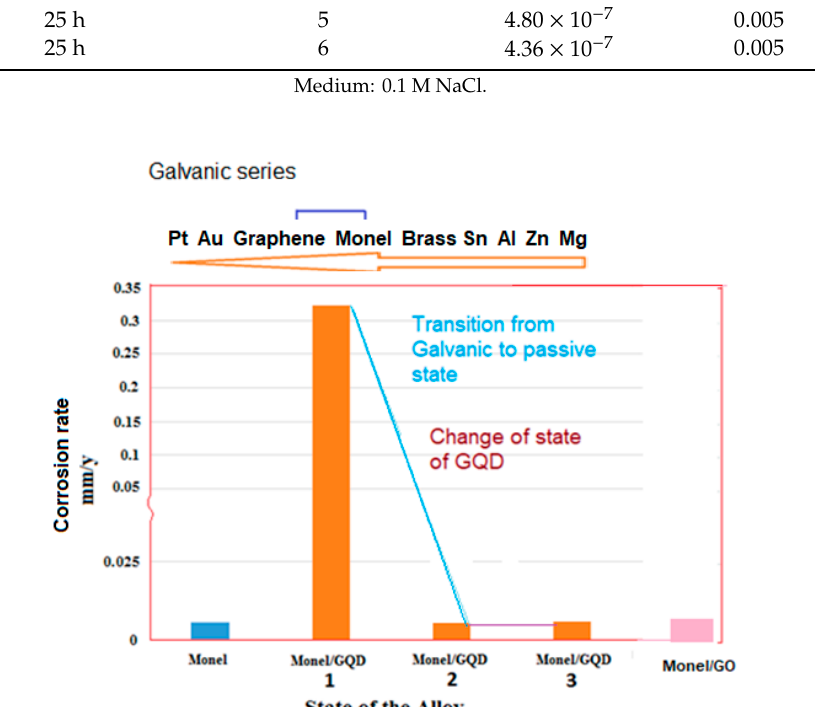
Figure 4. Monel alloy corrosion rates with coatings; 1, 2, 3 represent the polarization measurements.